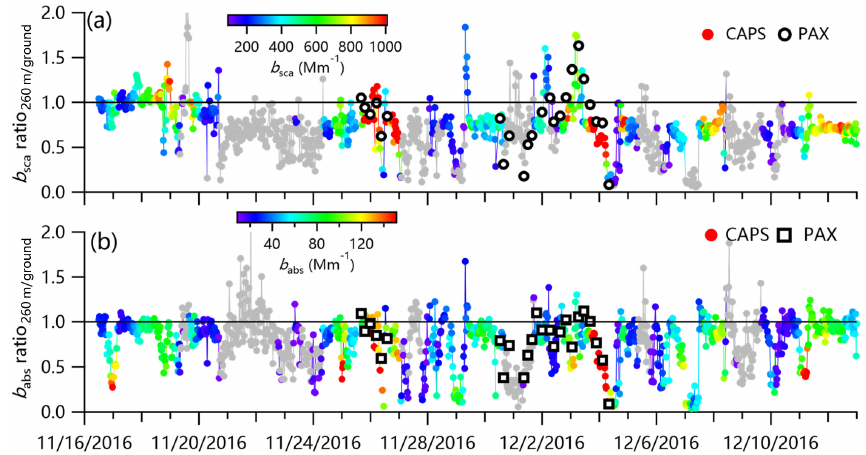
Figure 5. Time series of hourly average ratios 260m / ground for b sca and b abs during this study. The ratios are color coded by b ext , and the black circles and squares are those from continuous vertical measurements with PAX.